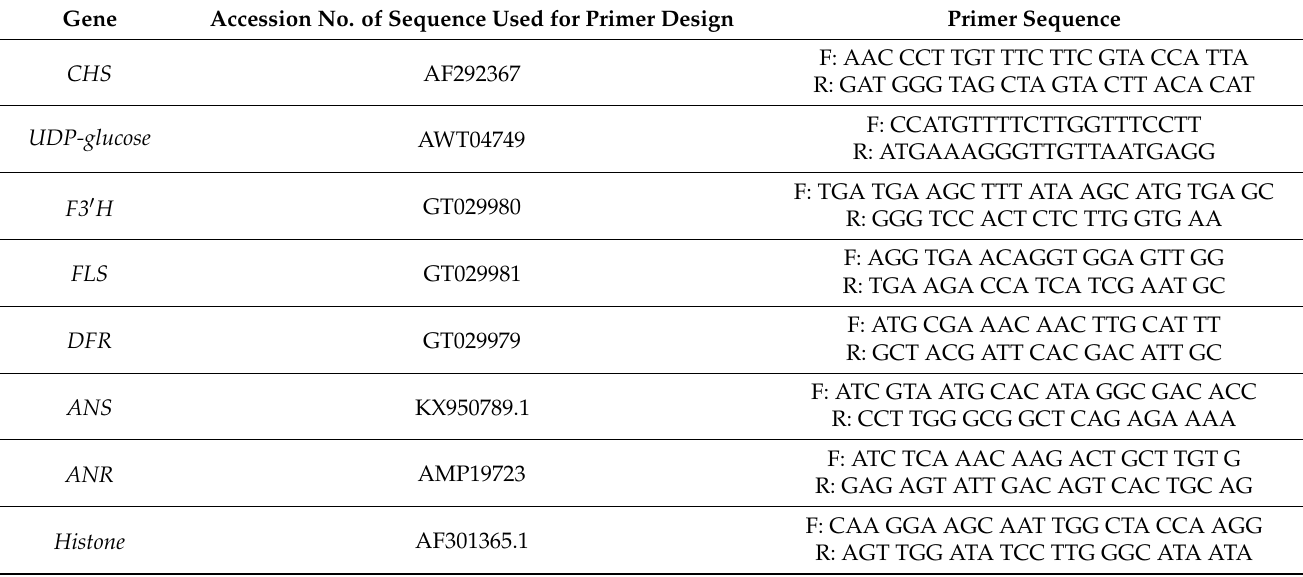
Table 1. The sequence of the primers used for the RT-PCR experiments.